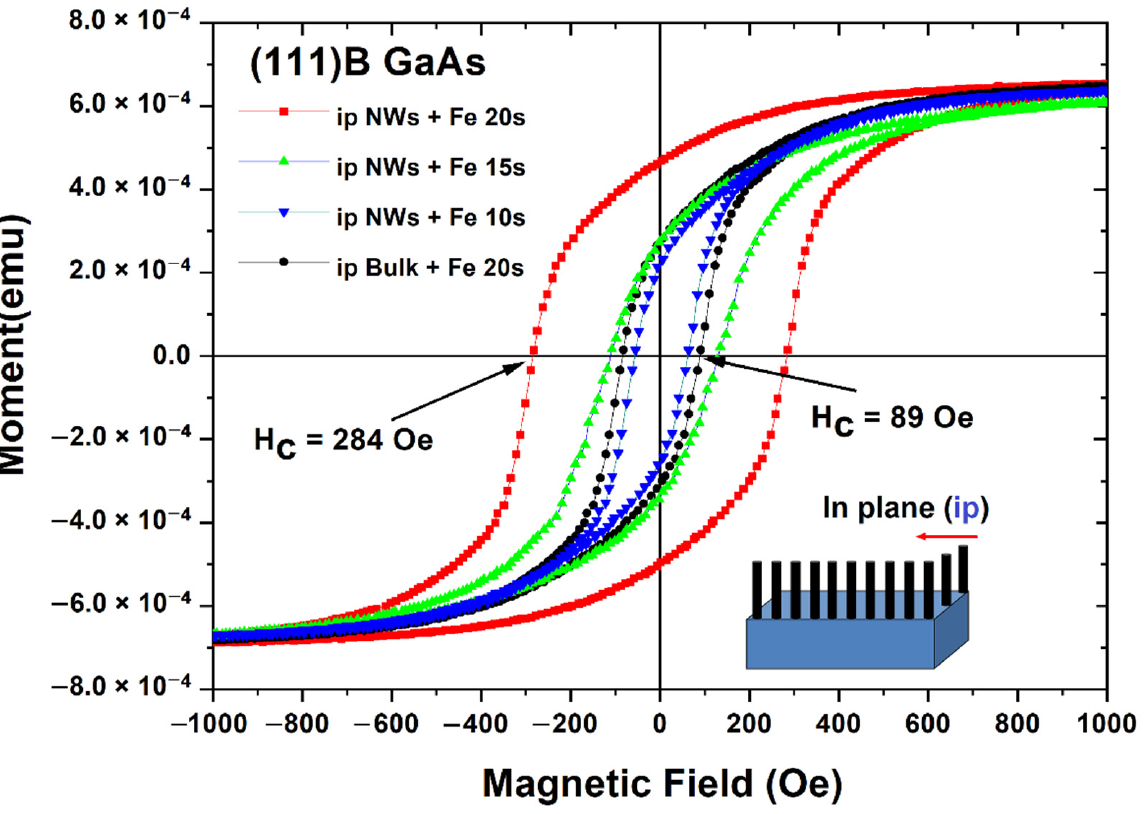
Figure 5. Hysteresis loops measured in in-plane configuration on nanowires array prepared on (111)B GaAs wafers compared with those measured on the substrate covered by a polycrystalline Fe film.